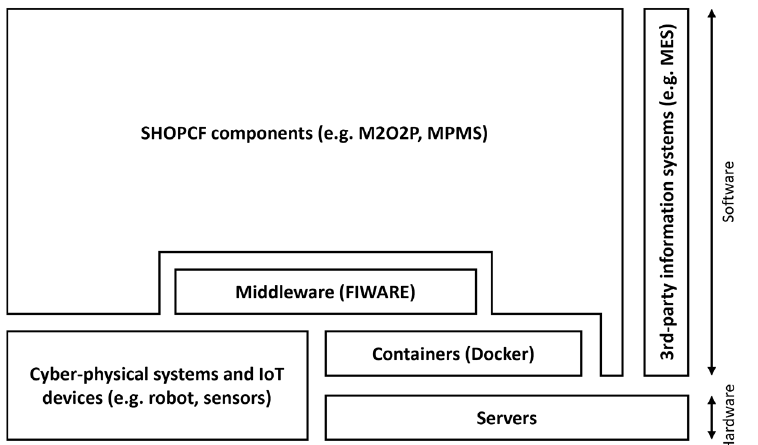
Figure 2. Top-level logical architecture of the platform [52]. The communication within the architec- ture happens through vertical neighborhood. SHOP4CF components communicate with each other using FIWARE and are primarily containerized, provided that an abstraction to the hardware layer was integrated.